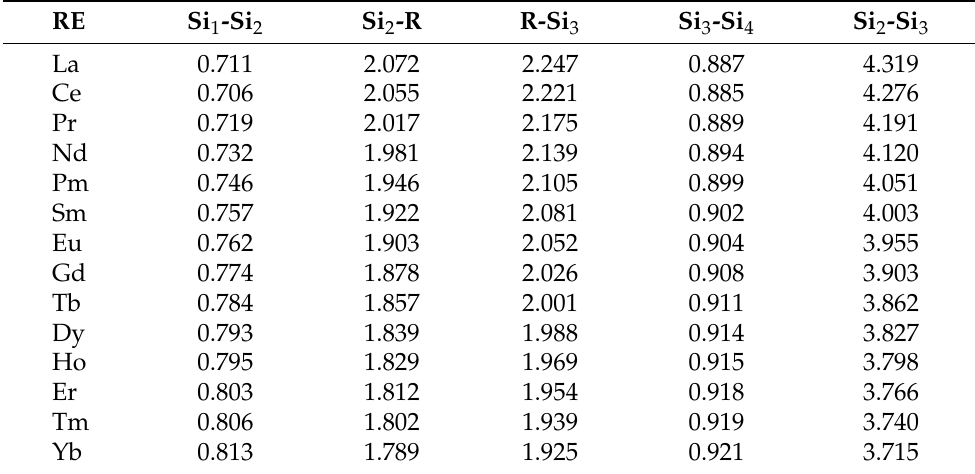
Table 2. Atomic layer distances (in Å) as calculated by DFT-PBEsol for the silicide monolayer structure with (1 × 1) periodicity of different rare earths. Labels as defined in Figure 4.